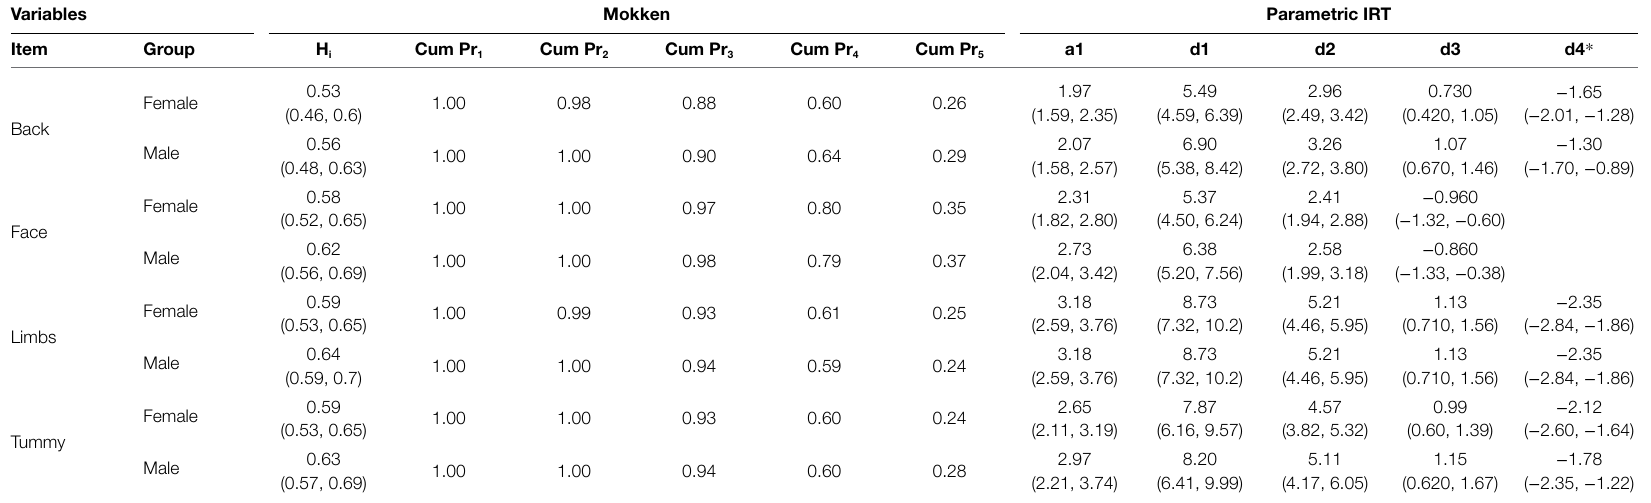
TABLE 5 | Female-Male comparison of stroking scale items for the United Kingdom cohort, by non-parametric (Mokken scaling) and parametric (IRT) DIF including: non-parametric scalability coefficients H i (and 95% CI), cumulative probability of responses ( Cum Pr), and parametric estimates with 95% CI of slope (a1) and intercept coefficients (d1–d4) for the IRT Graded Response Model (GRM). Variables Mokken